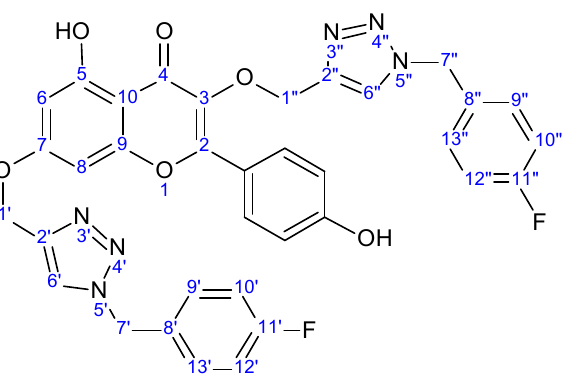
Figure 3. The skeleton numbering of compound 15 used for NMR assignment.